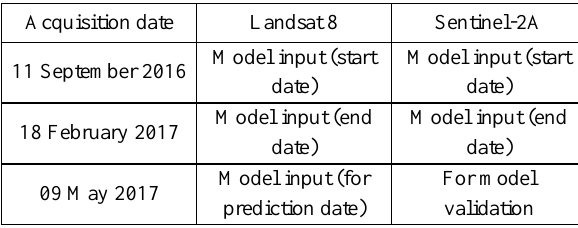
Table 2. The acquisition dates of every image used for the